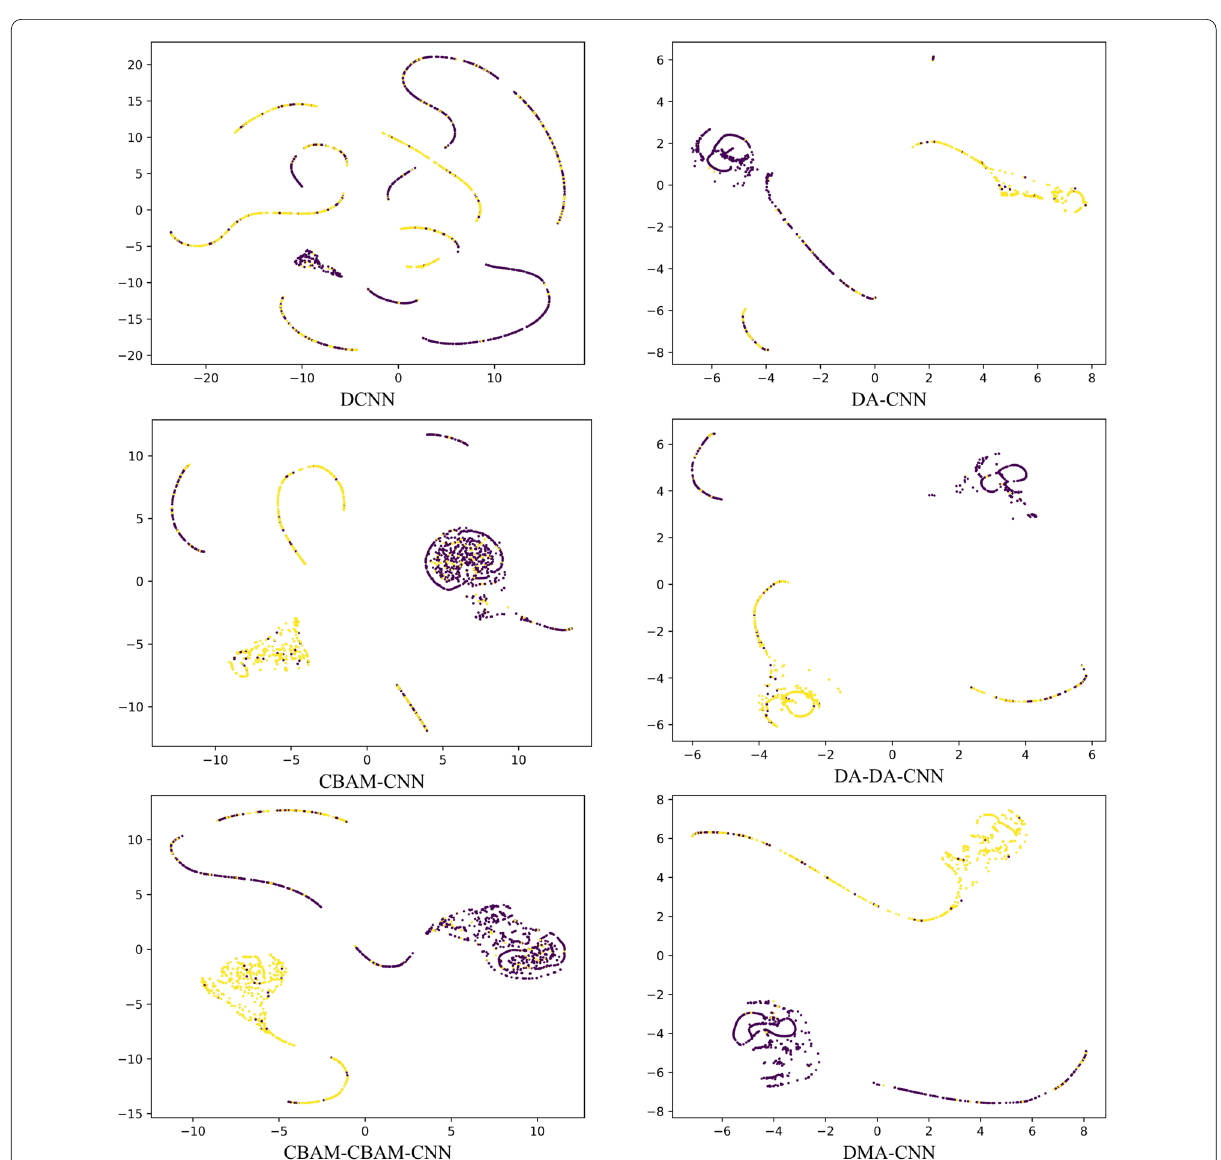
Figure 7 Visualization of experimental